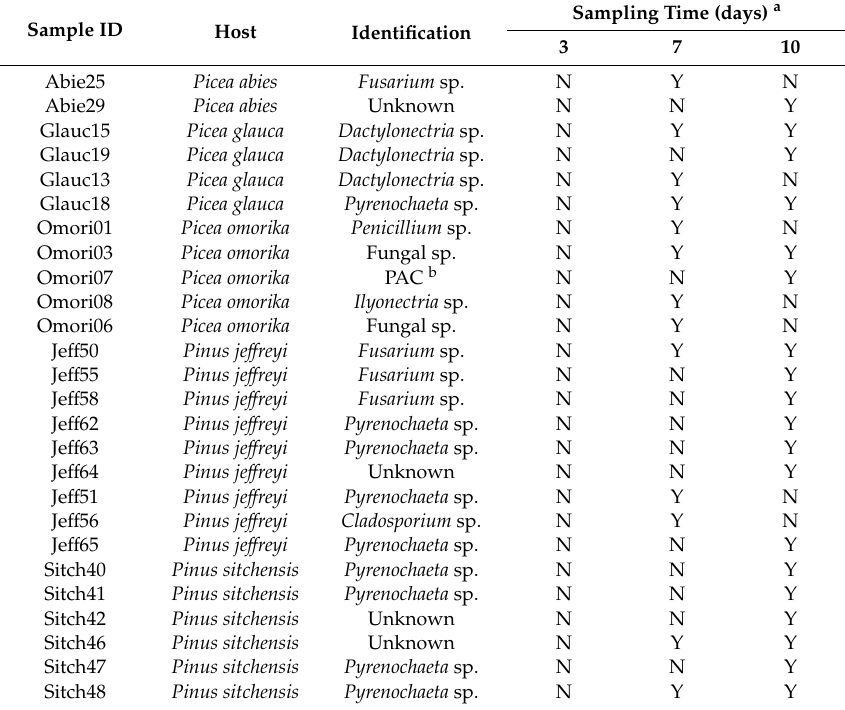
Table 4. Root endophytes identified as successful antagonists against the pathogen, H. parviporum , in the antagonism assay. These samples were identified on the basis of the significance of a t-test ( p -value = 0.05) comparing the mean spherical index of their pathogen partners ( n = 3 trials) with the mean spherical index of the pathogen controls ( n =